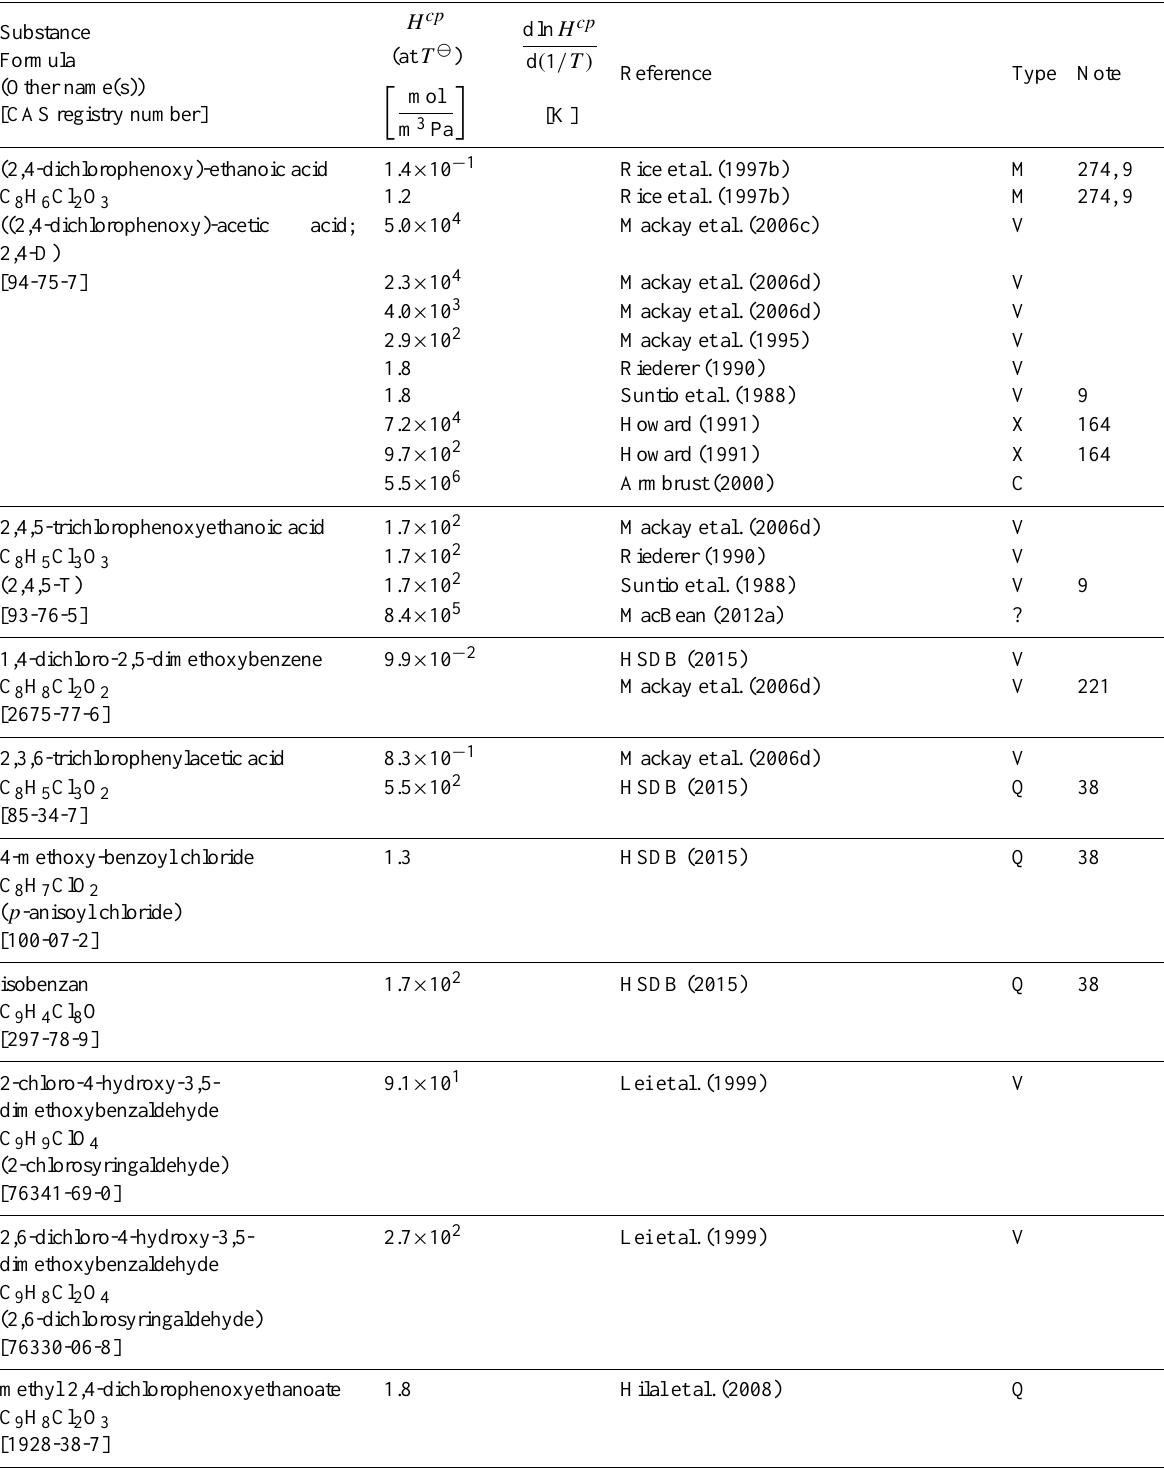
Table 6: Henry’s law constants for water as solvent